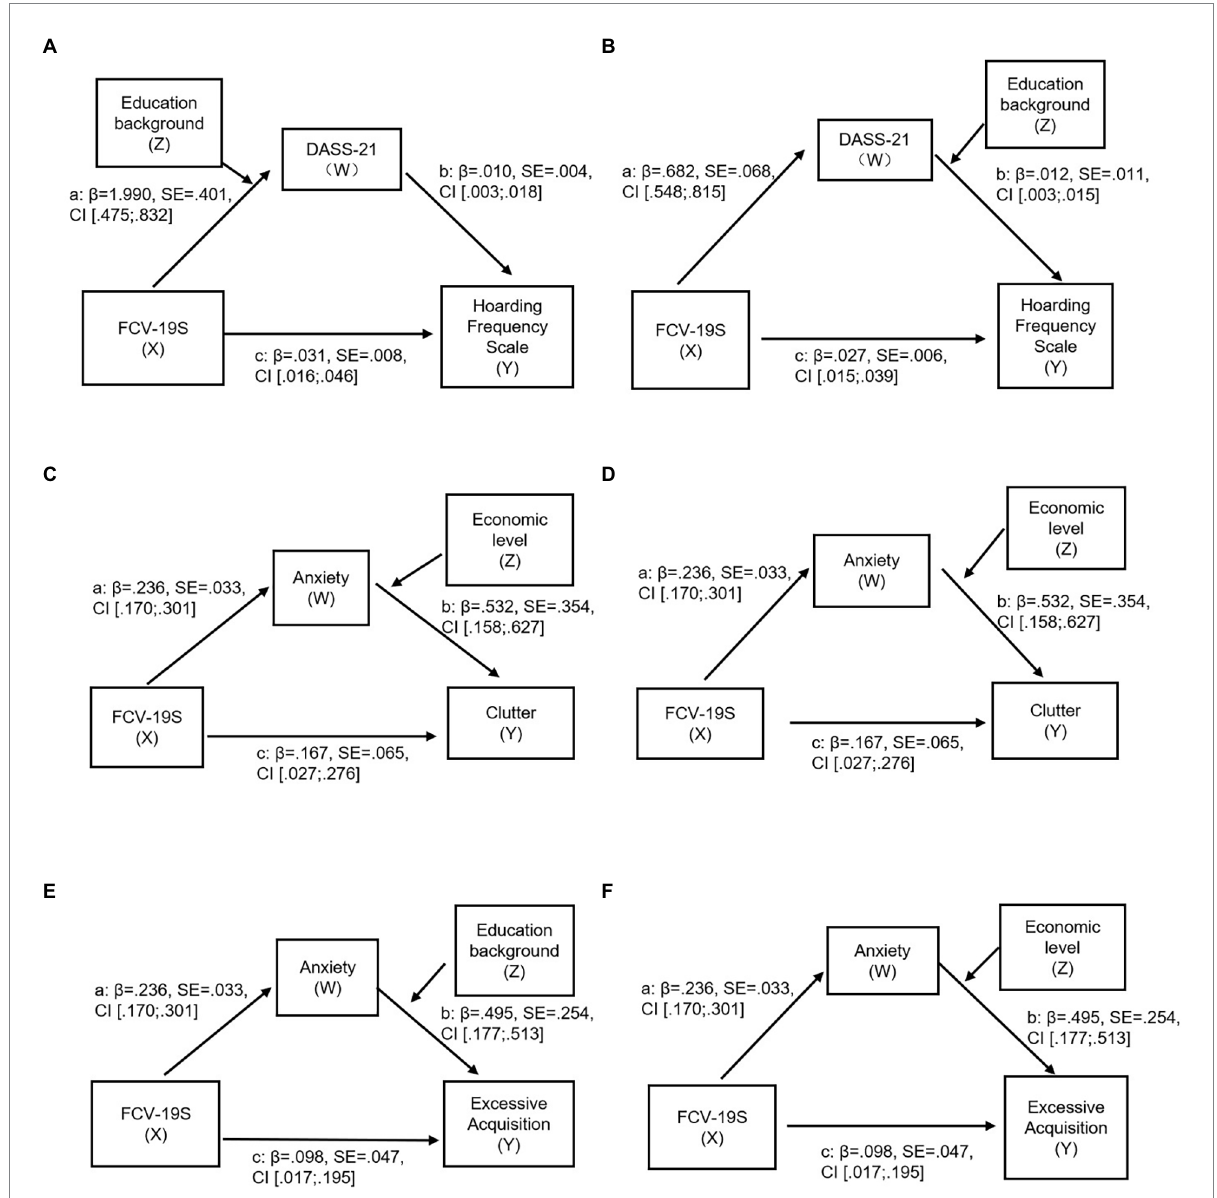
FIGURE 2 (A) DASS-21 mediating and moderating model of the correlation between FCV-19S scores and Hoarding Frequency Scale scores. c is the direct effect of FCV-19S scores and Hoarding Frequency Scale scores; a and b are the fully normalized indirect effects of DASS-21 (student sample). (B) DASS-21 mediating and moderating model of the correlation between FCV-19S scores and Hoarding Frequency Scale scores. c is the direct effect of FCV-19S scores and Hoarding Frequency Scale scores; a and b are the fully normalized indirect effects of DASS-21 scores (overall sample). (C,D) Anxiety mediating and moderating model of the correlation between FCV-19S scores and clutter. c is the direct effect of FCV-19S scores and clutter; a and b are the fully normalized indirect effects of anxiety (nonstudent sample). (E,F) Anxiety mediating and moderating model of the correlation between FCV-19S scores and excessive acquisition. c is the direct effect of FCV-19S scores and excessive acquisition; a and b are the fully normalized indirect effects of anxiety (nonstudent